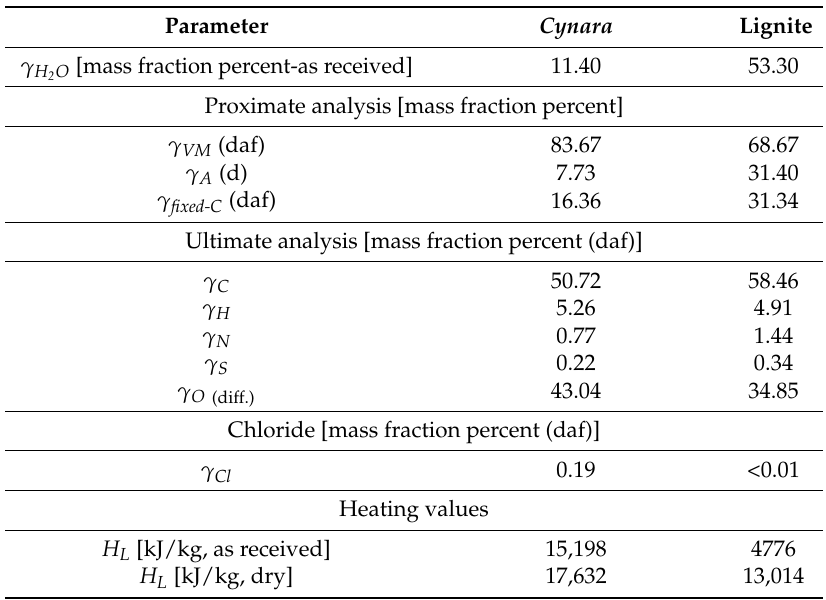
Table 2. Characteristics and energy contents of the